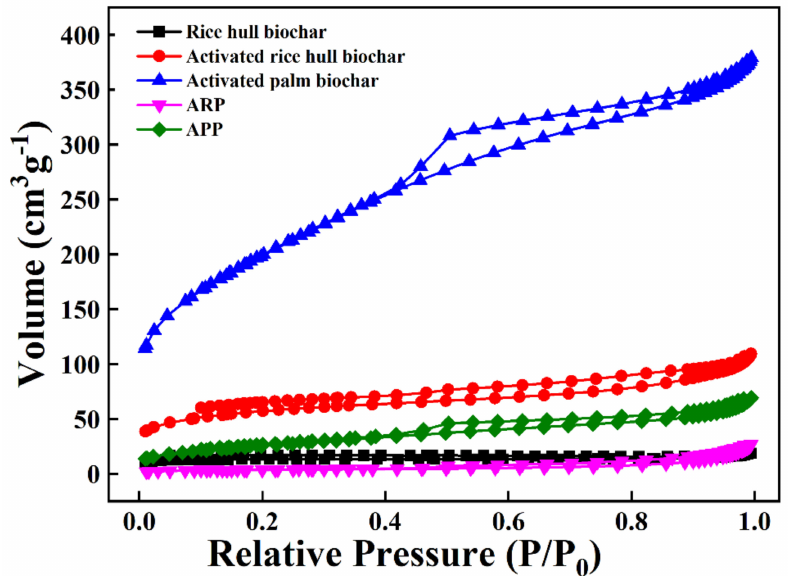
Figure 3. N 2 adsorption–desorption isotherm of the different types of used materials. ARP: